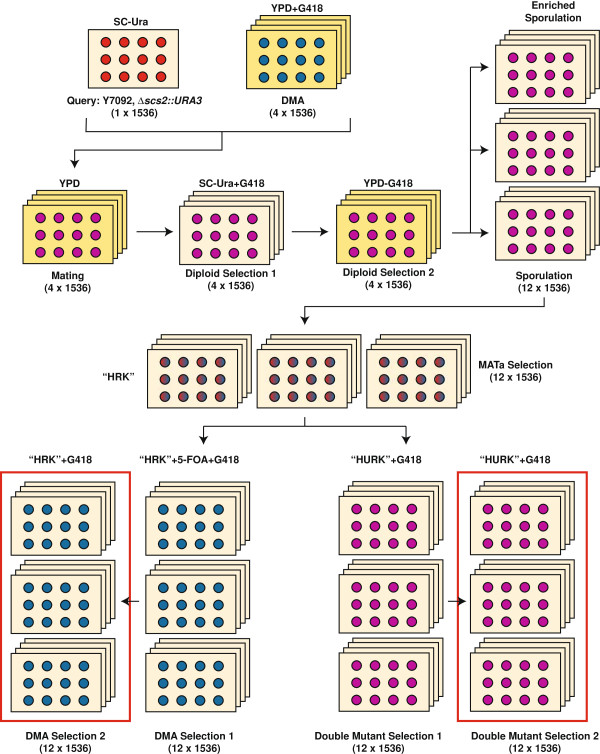
Experimental procedure for an SGA screen for SCS2. SC–synthetic complete medium; “HRK”–SC minus histidine/arginine/lysine, plus canavnine (100 mg/L) and thialysine (100 mg/L); “HURK”–as HRK, but minus uracil; 5-FOA–5-fluoroorotic acid.